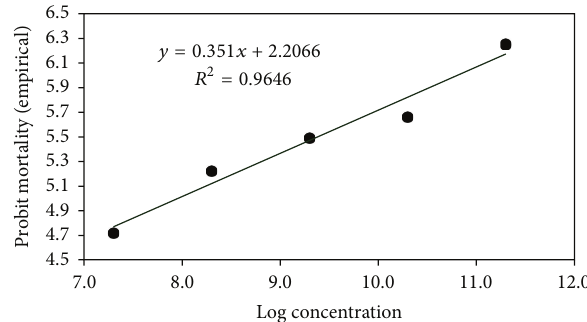
Figure 6: Log concentration probit mortality response of A. dispersus to B. bassiana (B1 strain).